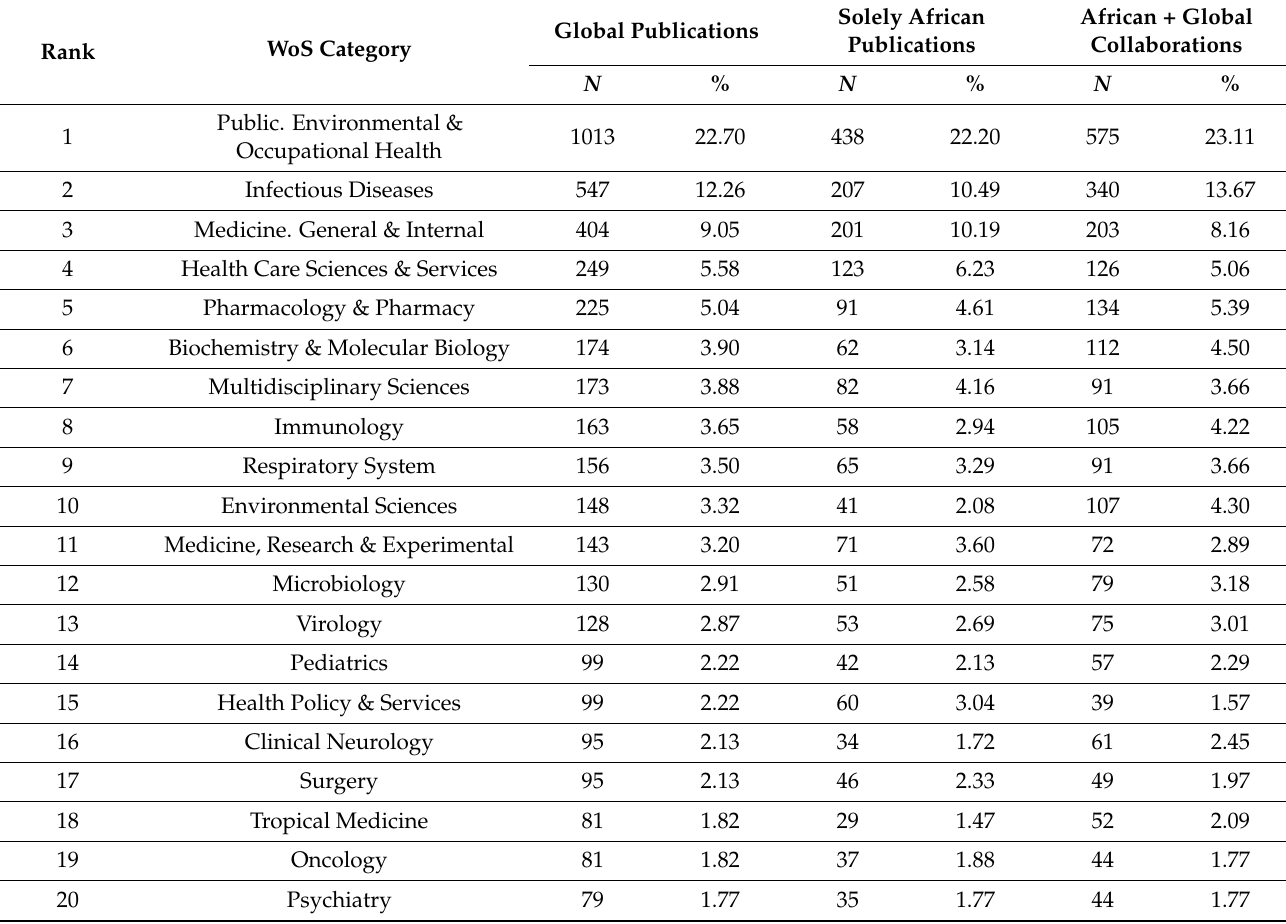
Table 5. COVID-19-related research papers broken down by Web of Science categories, according to African involvement. N represents the number of